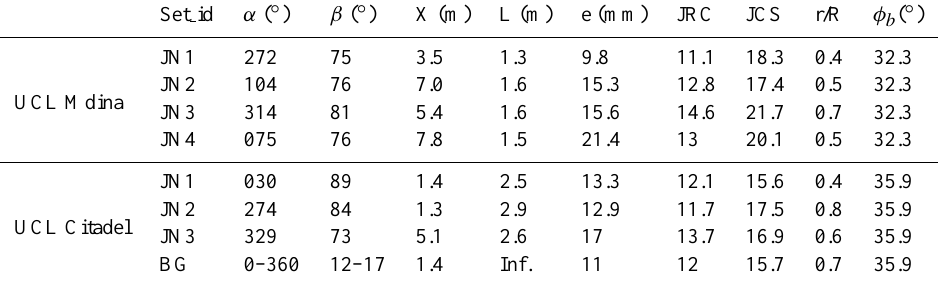
Table 1. Geomechanical properties of the rock mass discontinuities. Set id: joint set identification code; α : dip direction; β : dip; X: true spacing; L: persistence; e: aperture; JRC: Joint Roughness Coefficient; JCS: Joint Compressive Strength; r: Schmidt hammer rebound number on wet and weathered fracture surfaces; R: Schmidt hammer rebound number on dry unweathered surfaces; φ b : basic friction angle. Set